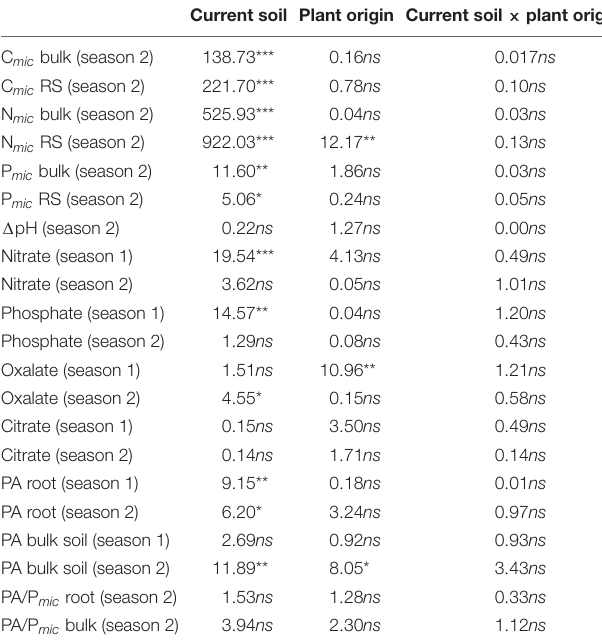
and were grown in material from the Bv horizon at BBR or from the Bh horizon at LUE (factor “current soil”); shown are F ( 1 , 14 ) values for the factors and